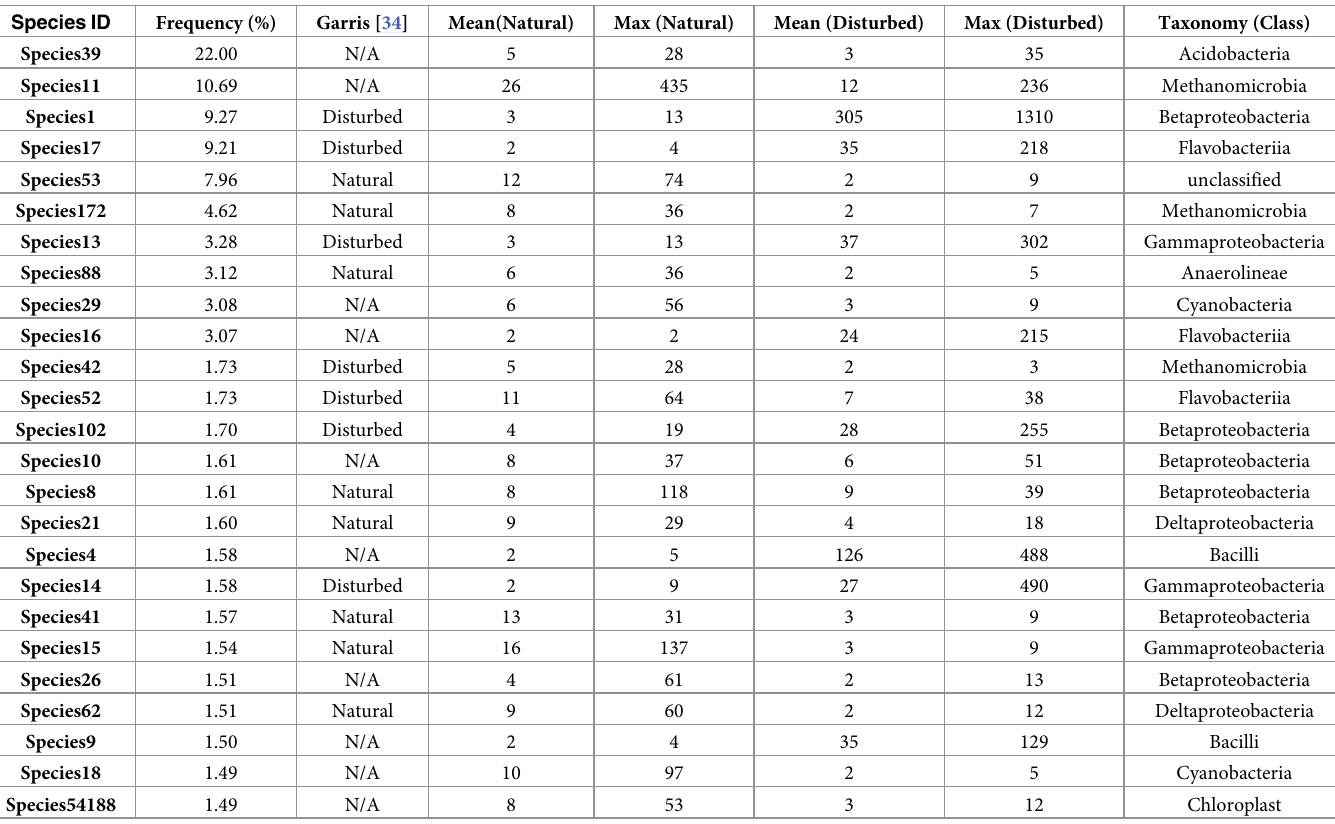
Table 8. Indicator species identified by our proposed feature extractor, compared to those identified by [34]. The Frequency column denotes the number of times each species has been identified as a top weight, divided over all 5000 experiments. The Garris column represents whether each species has been identified in the paper [34], and if so, which habitat it belongs to. The maximum and mean abundance counts of each species are also shown, along with the Class taxonomy